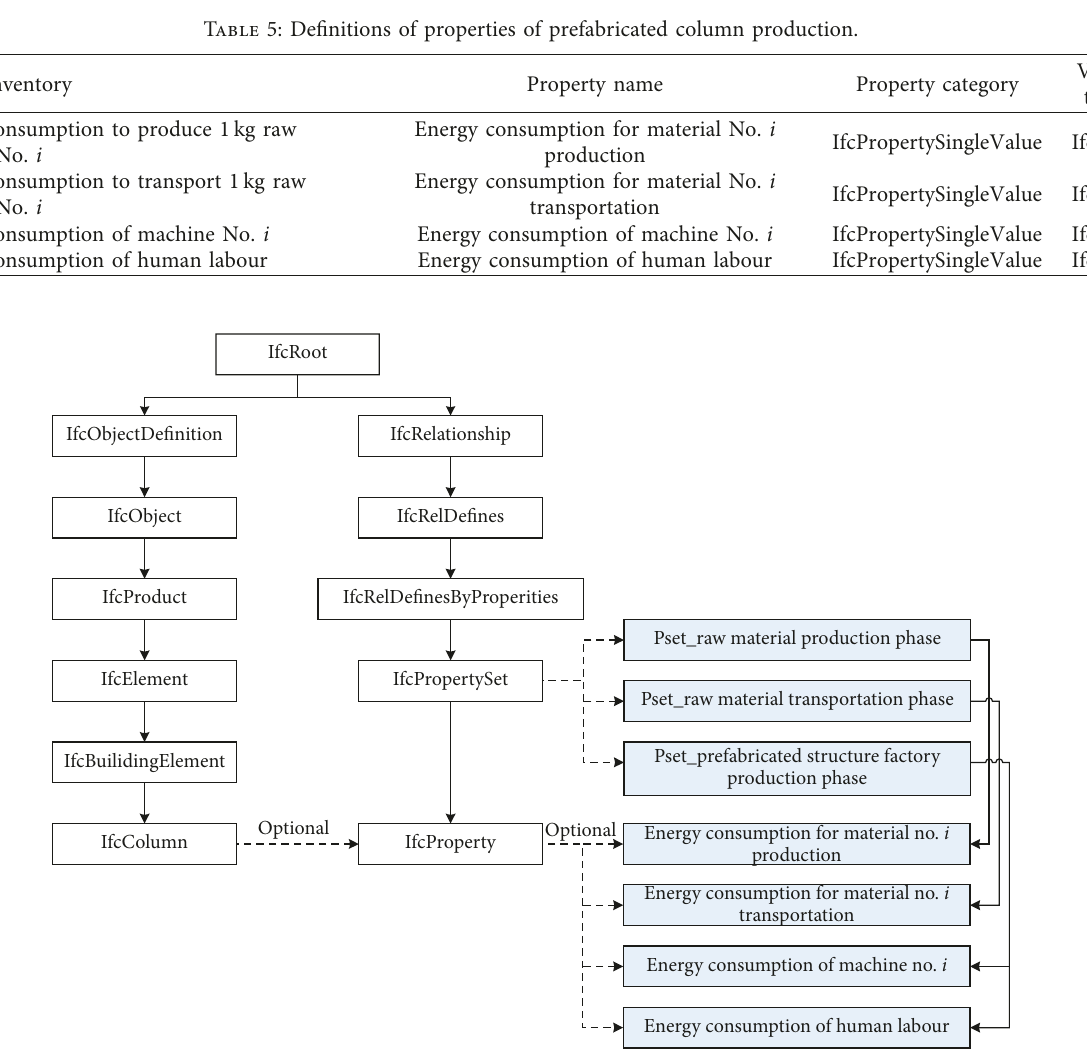
Figure 6: IFC expression of energy consumption of prefabricated